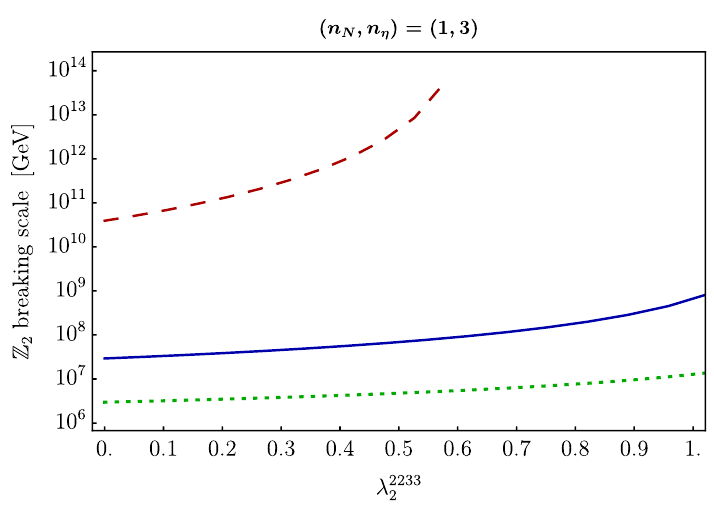
Figure 5 . Z 2 breaking scale as a function of the (cid:21) 2233